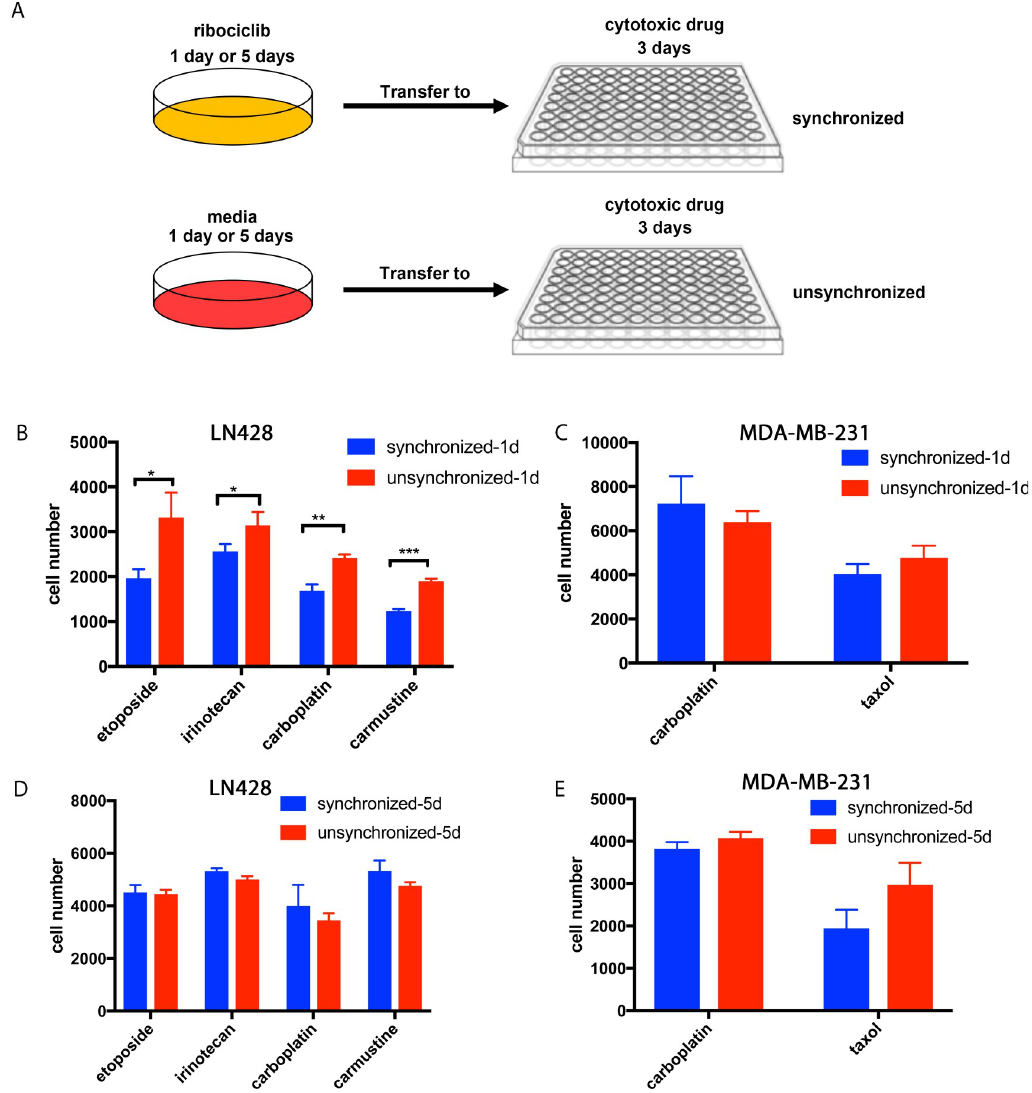
Fig 4. Synchronized release from ribociclib-induced G1/S checkpoint arrest did not increase cytotoxicity of cytotoxic drugs. (A) Diagrams of experimental and control treatment schedule based on the synchronization-release schedules shown in Fig 3. (B-C) Representative graphs of 3 independent repeats of the cytotoxicity assay in indicated cells treated with indicated cytotoxic drugs after the 1-day synchronization-1-day release regime as shown in A. (D-E) Representative graphs of 3 independent repeats of the cytotoxicity assay in indicated cells treated with indicated cytotoxic drugs after the 5-day synchronization-1-day release regime as shown in A. All values are numbers of live cells remaining in culture at the end of treatment and presented as Mean (SD). P-value was calculated using 2-sided T-test: � , p < 0.05; �� , p < 0.01; ��� , p < 0.001.